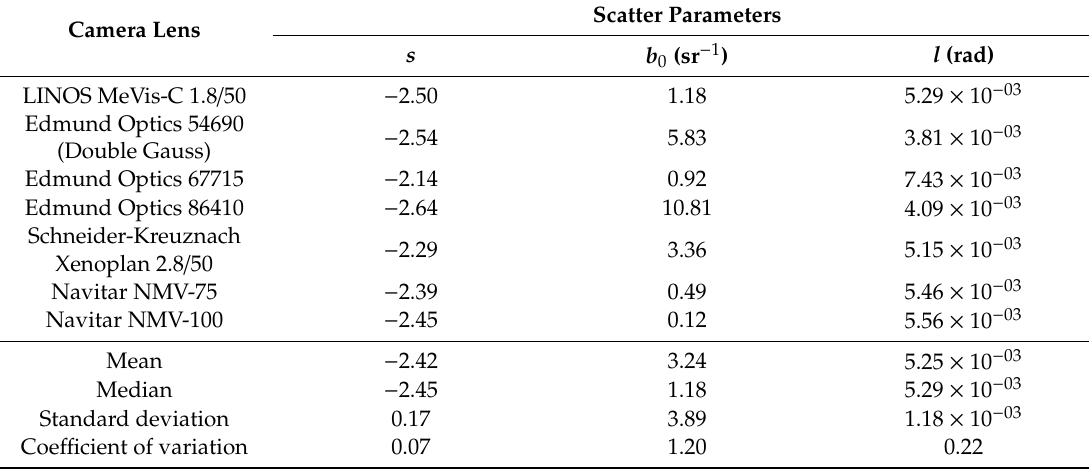
Figure 11. Typical irradiance profile in the focal plane of a camera lens. The vertical lines mark the scatter parameter l . Table 3. Scatter parameters of the camera lenses to be used in the 3-paramater Harvey scatter model, related to a reference wavelength of 550